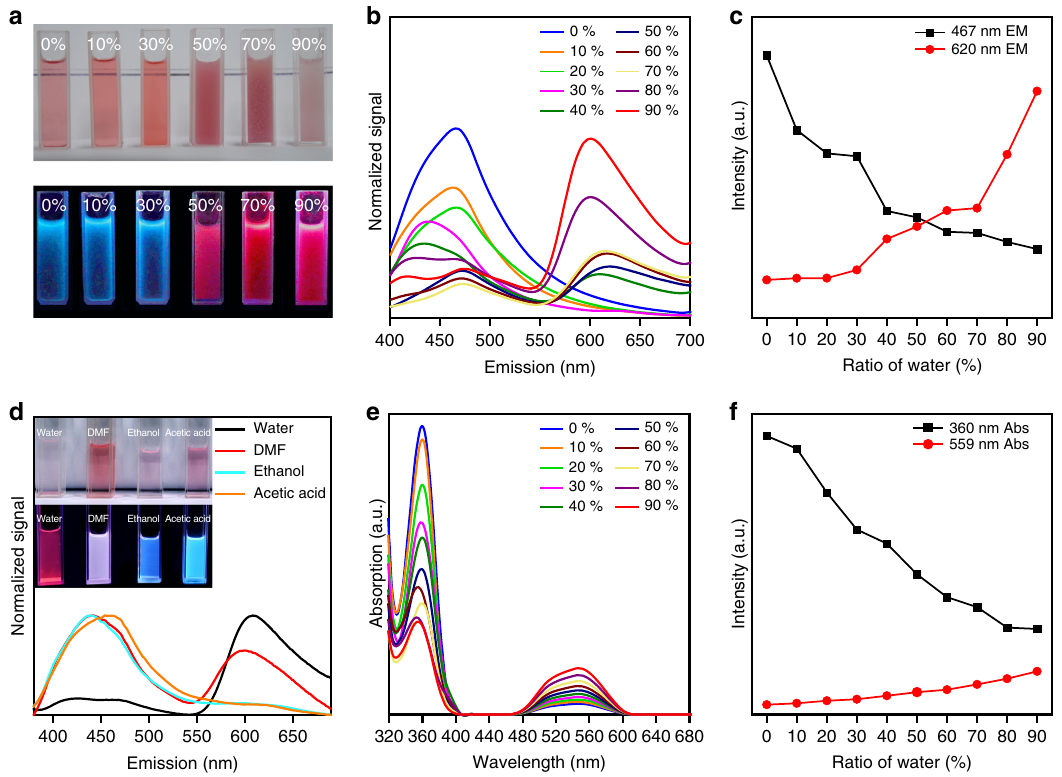
Fig. 4 H-CDs ’ absorption and emission varied with different solvent. a Photographs of the as-prepared H-CD solution with varying volume ratios of water (from 0 to 90%) under sunlight (top) and 365 nm ultraviolet radiation (bottom). b PL emission spectra of the H-CD as-prepared solution with varying ratios of water. c Trend of the H-CD as-prepared solutions ’ fl uorescence intensity at 467 and 620 nm, varying with the ratio of water. d PL emission spectra of the H-CD powder solutions in different solvents (insets: photographs of the H-CD powder solutions in solvents with different polarities (from high to low) under sunlight (top) and 365 nm ultraviolet radiation (bottom)). e UV − Vis absorption spectra of the H-CD as-prepared solution with different ratios of water. f Trend of the H-CD as-prepared solutions ’ absorbance at 360 and 559 nm, varying with the ratio of water. H-CD, hydrophobic carbon